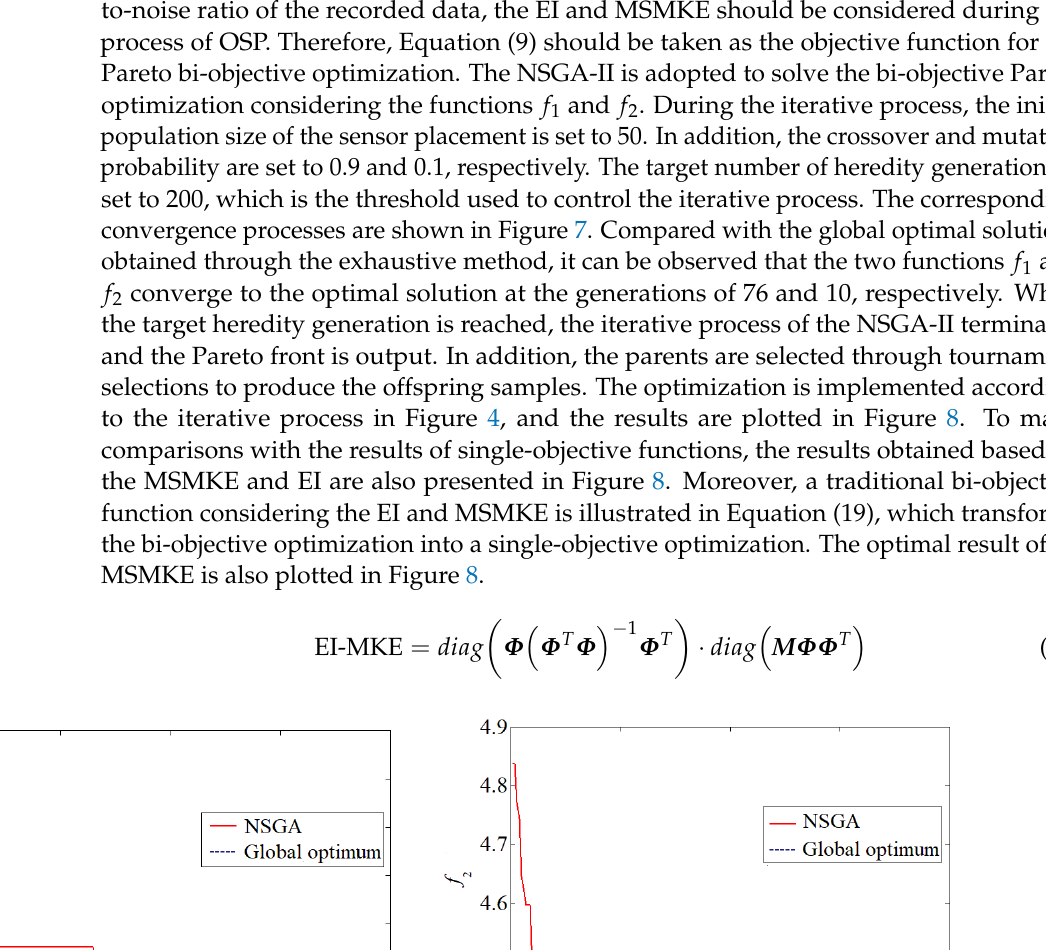
Figure 8. Optimal solutions of sensor placement based on the criteria of EI and MSMKE (